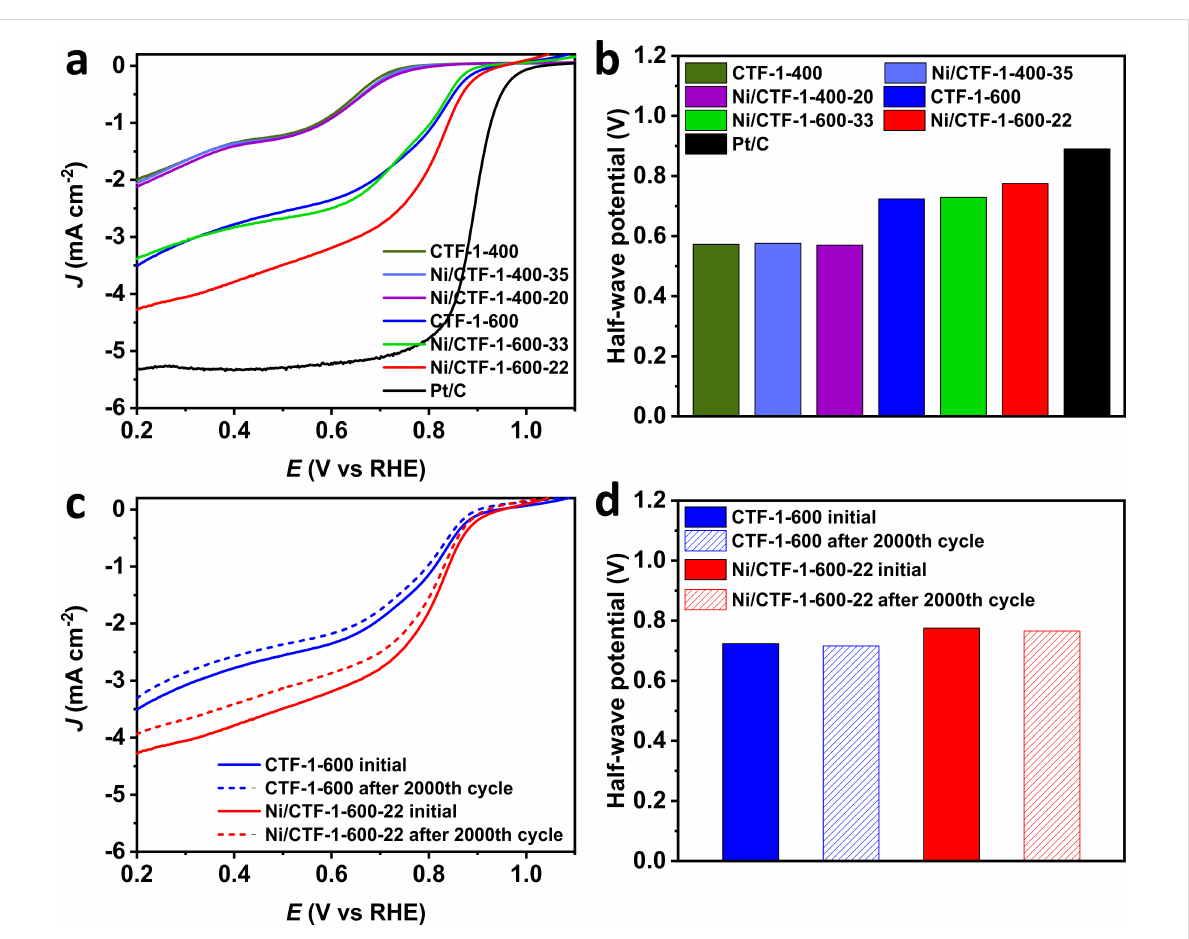
Figure 8: (a) ORR polarization curves of various materials, (b) half-wave potential values calculated from (a); (c) ORR polarization curves for CTF-1- 600 and Ni/CTF-1-600-22 after 2000 cycles, (d) half-wave potential values calculated from (c).